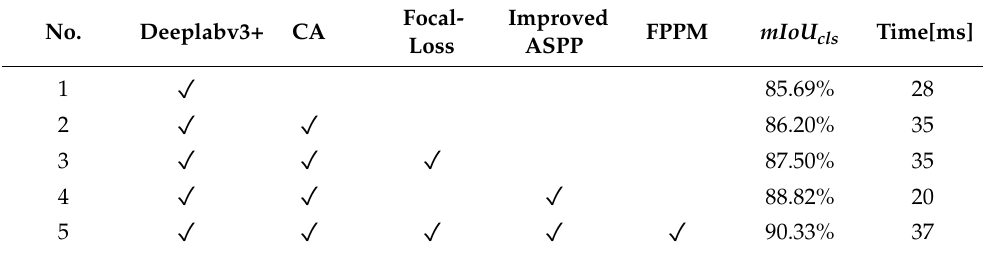
Table 3. Analysis of Deeplabv3+ model ablation experiment.